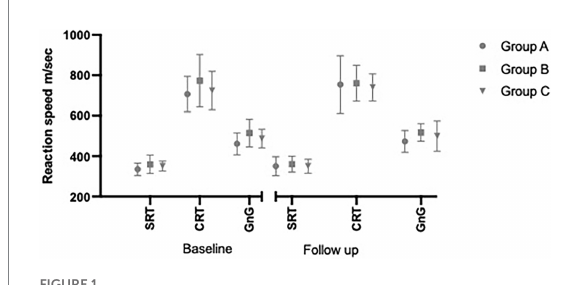
FIGURE 1 Cognitive test for all groups A–C at baseline and follow-up; the